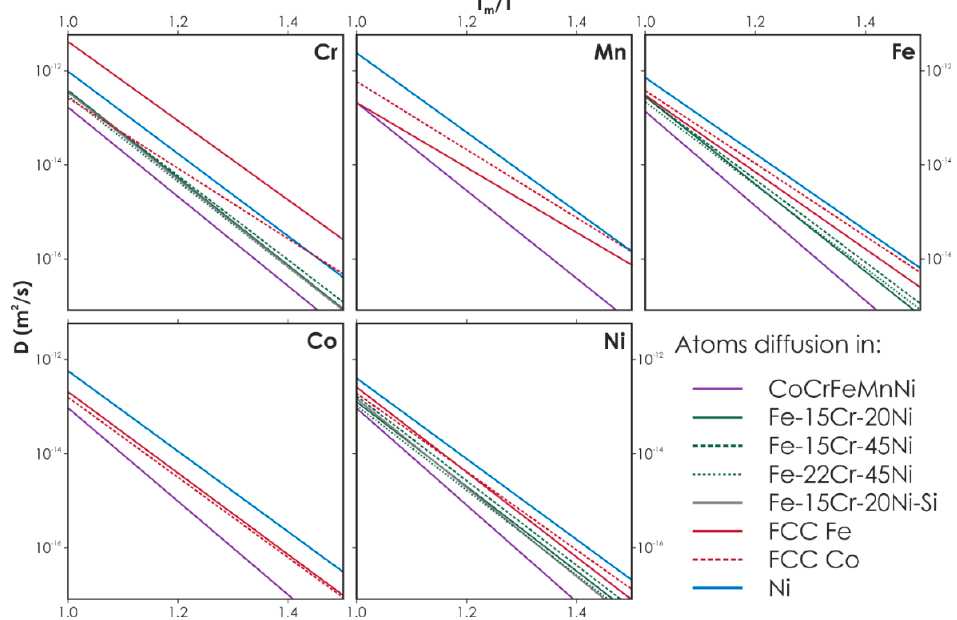
Figure 2. Temperature dependence of the tracer diffusion coefficients for Cr, Mn, Fe, Co, and Ni in different matrices (after [28]), presented as a function of the normalized temperature. Reprinted from Acta Materialia 61 (2013), Sluggish diffusion in Co–Cr–Fe–Mn–Ni high-entropy alloys, 4887–4897 Copyright 2013, with permission from Elsevier.